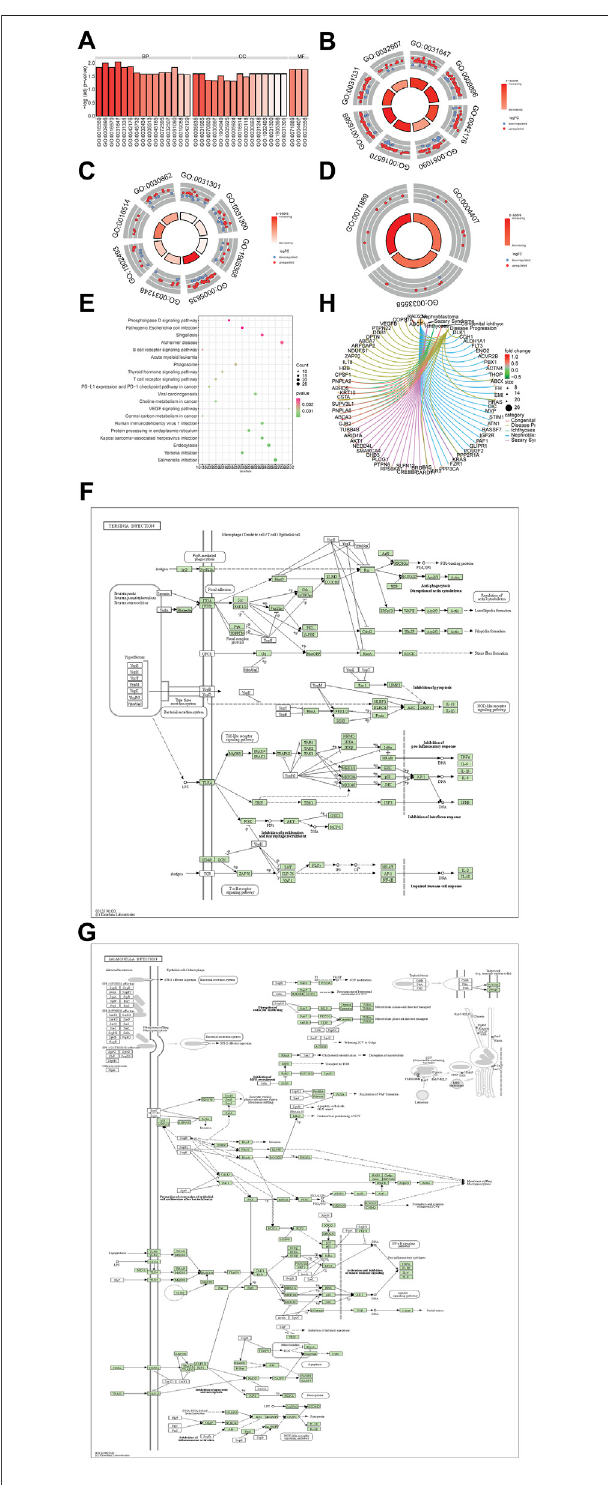
FIGURE 3 | Functional enrichment analysis of the TSEs. (A – D) : Enrichment analysis of TSEs in the GO BP, MF, and CC categories. (A) : The abscissaisthez-score,andtheordinateis − log(adjusted p -value). (B – D) :The color of the node indicates the expression value: red indicates upregulated expression, and green denotes downregulated expression. The